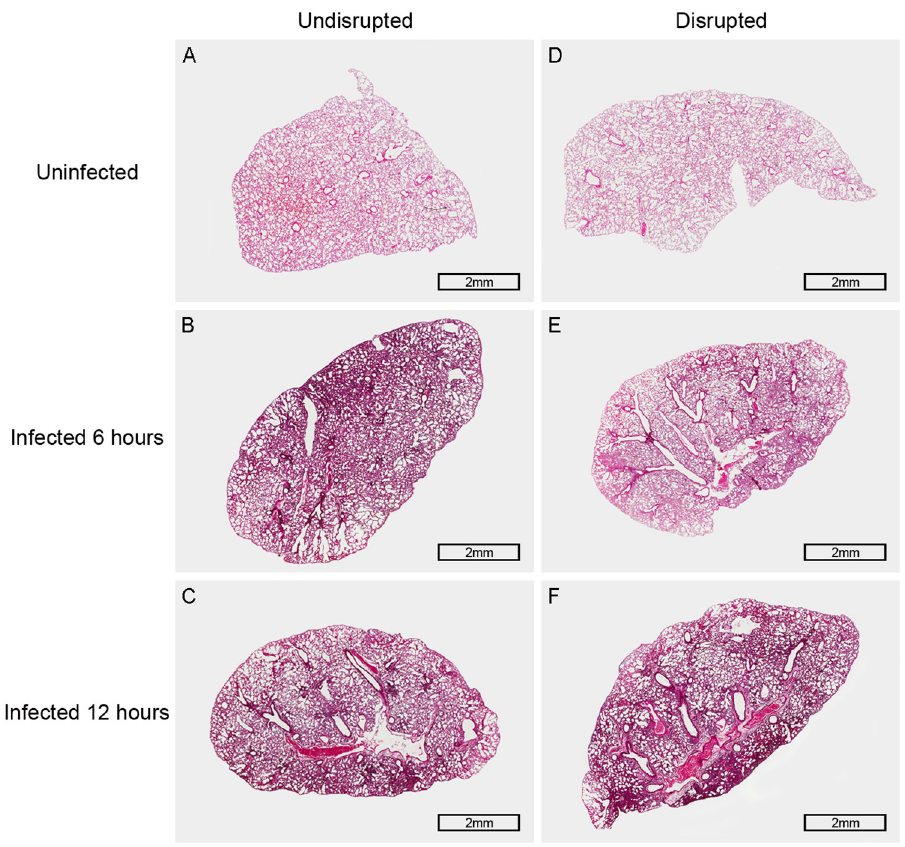
Fig 4. Histopathology of the lung in TLR4-deficient mice 6 hours and 12 hours after pneumococcal infection. Representative pictures of H & E stained lung tissues: (A) The picture of the lung tissue in gut microbiota-undisrupted uninfected mice (n = 6 per group). (B and C) Pictures of the lung tissue in gut microbiota-undisrupted mice 6 hours and 12 hours after infection (n = 6 per group). (D) The picture of the lung tissue in gut microbiota-disrupted uninfected mice (n = 6 per group). (E and F) Pictures of the lung tissue in gut microbiota-disrupted mice 6 hours and 12 hours after infection (n = 6 per group). Original magnification, × 20; scale bar = 2 mm.